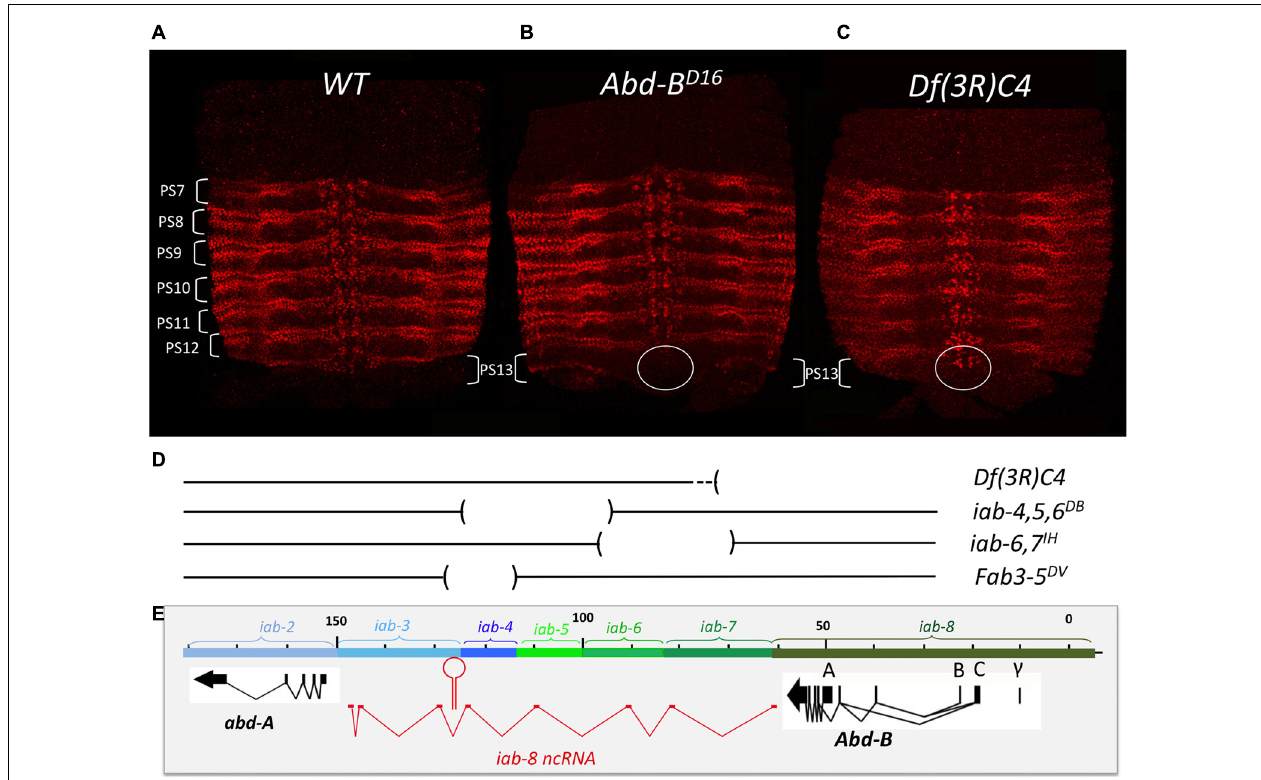
expansion. Panel C shows a homozygous Df(3R)C4 mutant embryo in which abd-A expansion in PS13 occurs in both epidermis and CNS (circled; original observation published in Gummalla etal., 2012). Panel D depicts the extend of the various deficiencies we used in our unsuccessful attempts to locate a second discrete repressive mechanism (see page 13). Panel E , same as panel D in Figure 2